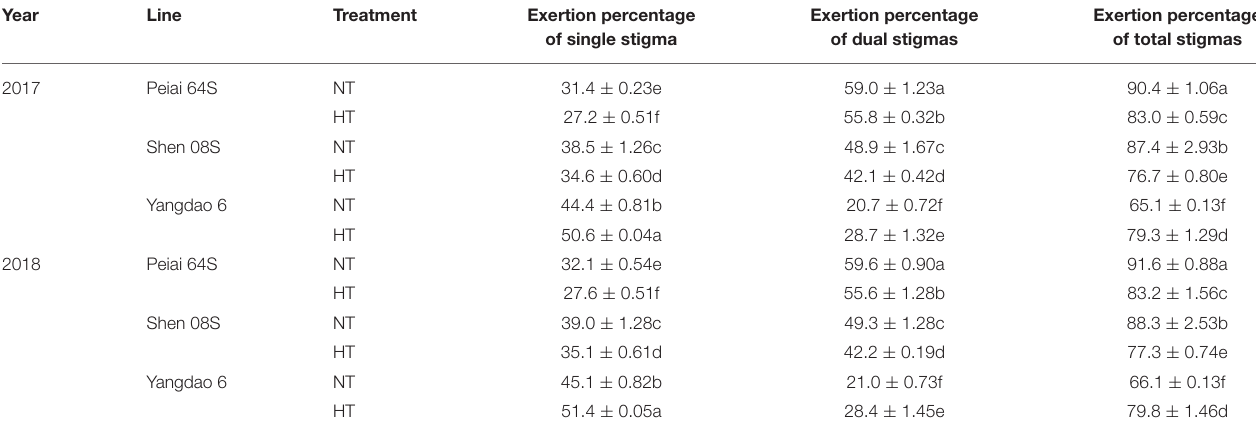
TABLE 1 | Effect of high-temperature stress during anthesis on stigma exertion of